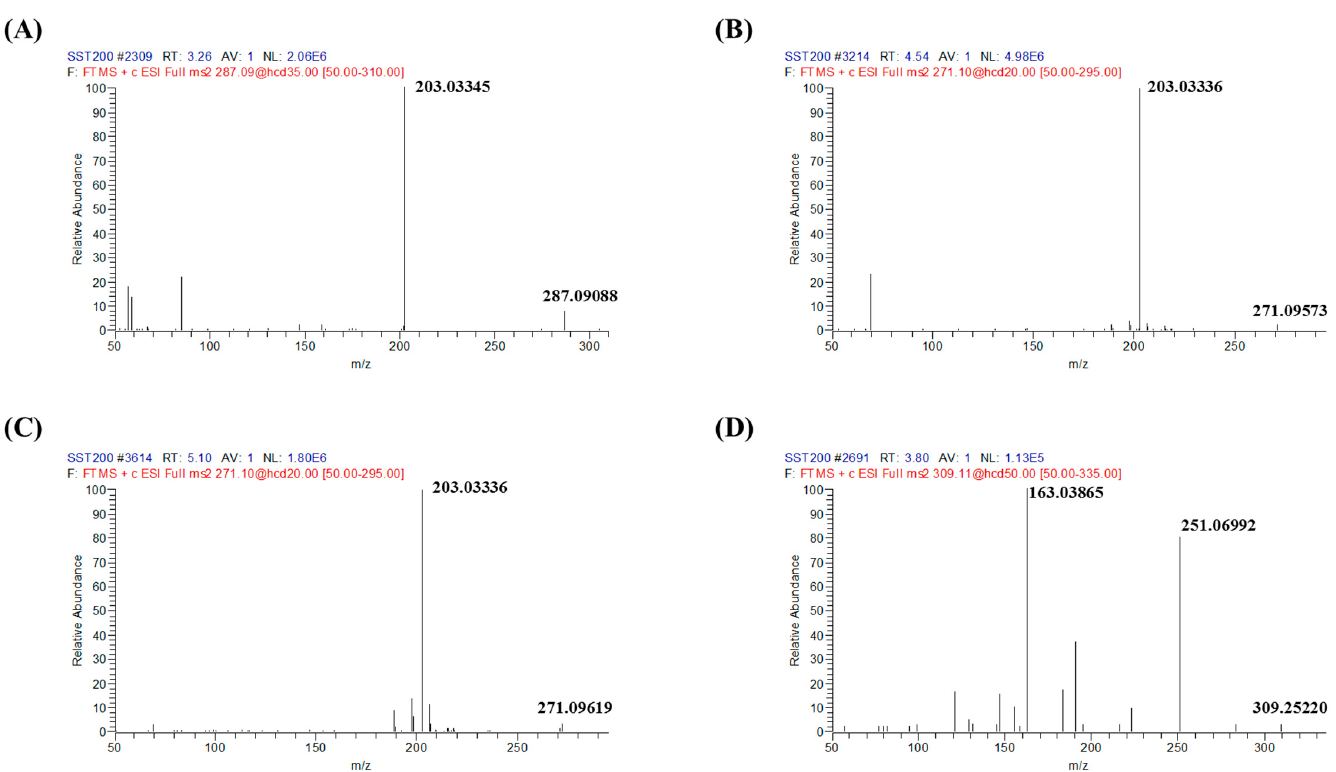
Figure 2. Mass spectrum of the analytes and internal standard (IS). Production m / z transitions for oxypeucedanin ( A ); imperatorin ( B ); isoimperatorin ( C ); and warfarin (IS, D ) were selected 287.09088 → 203.03345, 271.09573 → 203.03336, and 309.25220 → 163.03865, respectively.